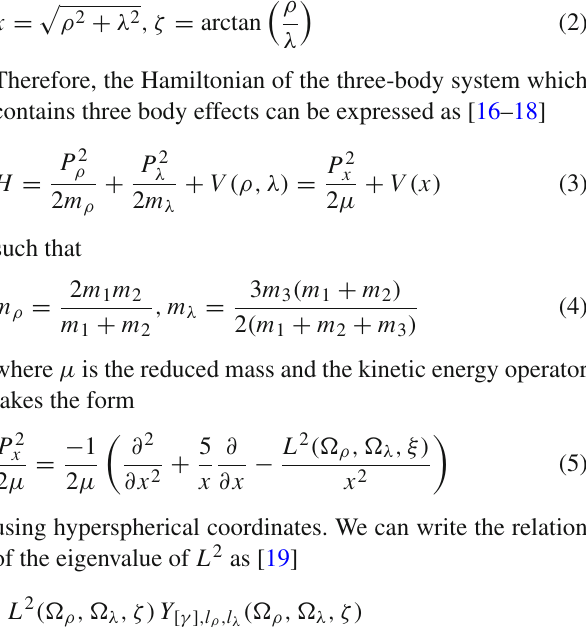
μ 2 α 2 + V , V ( x ) = − 2 α s 0 2 s x 2 π + 0 . 148 x